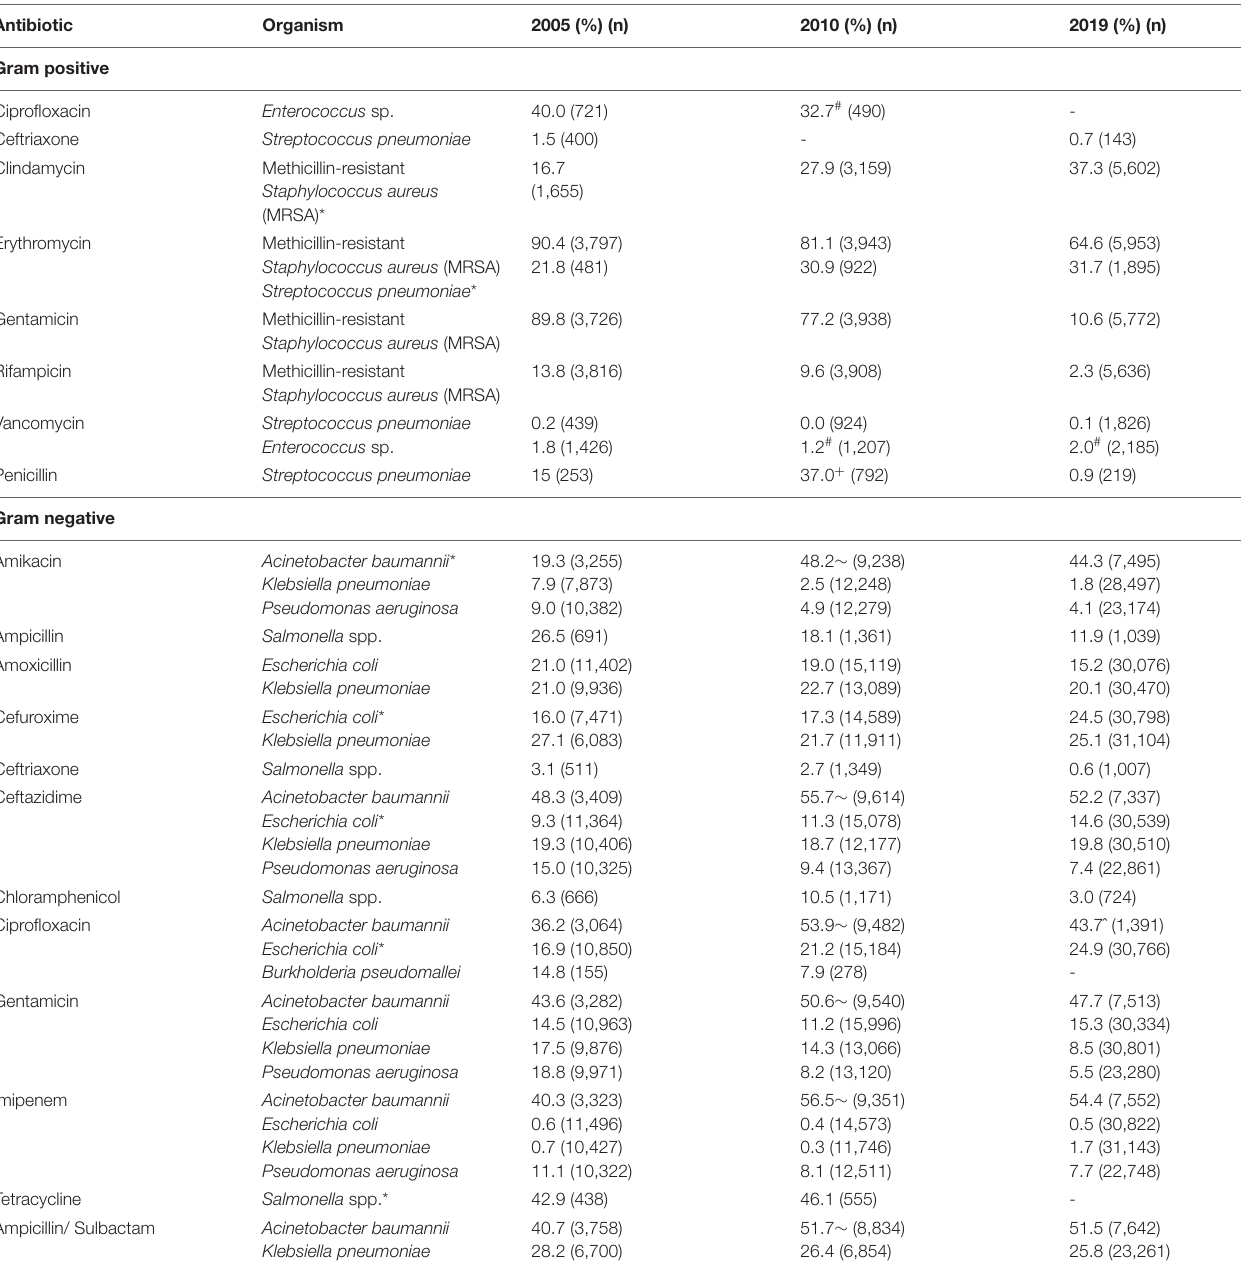
TABLE 1 | Antimicrobial resistance of Gram-negative and Gram-positive organisms causing human infections in Malaysia (National Surveillance of Antibiotics Resistance [NSAR] 2005, 2010, and 2019; Institute of Medical Research [IMR], 2020). Antibiotic